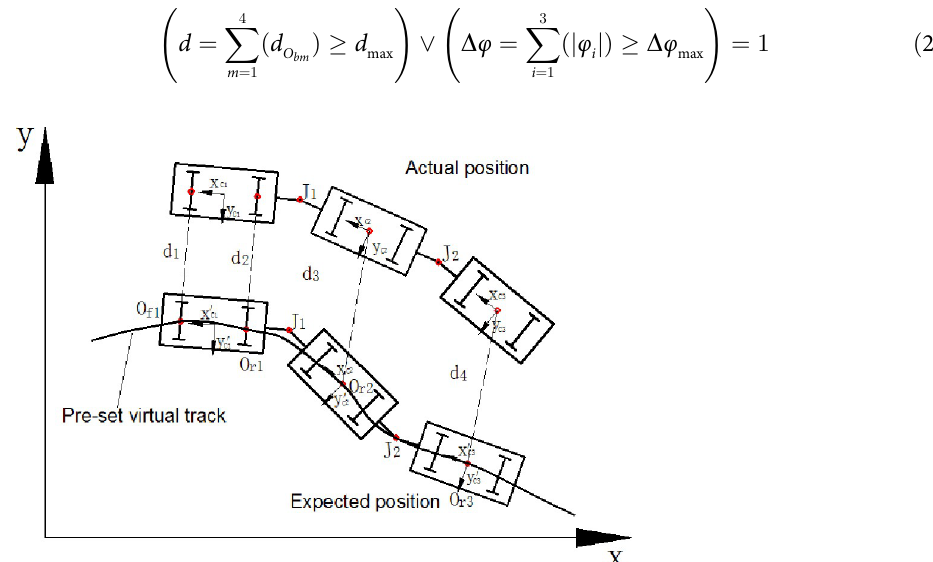
Fig 5. The tracking error of the whole